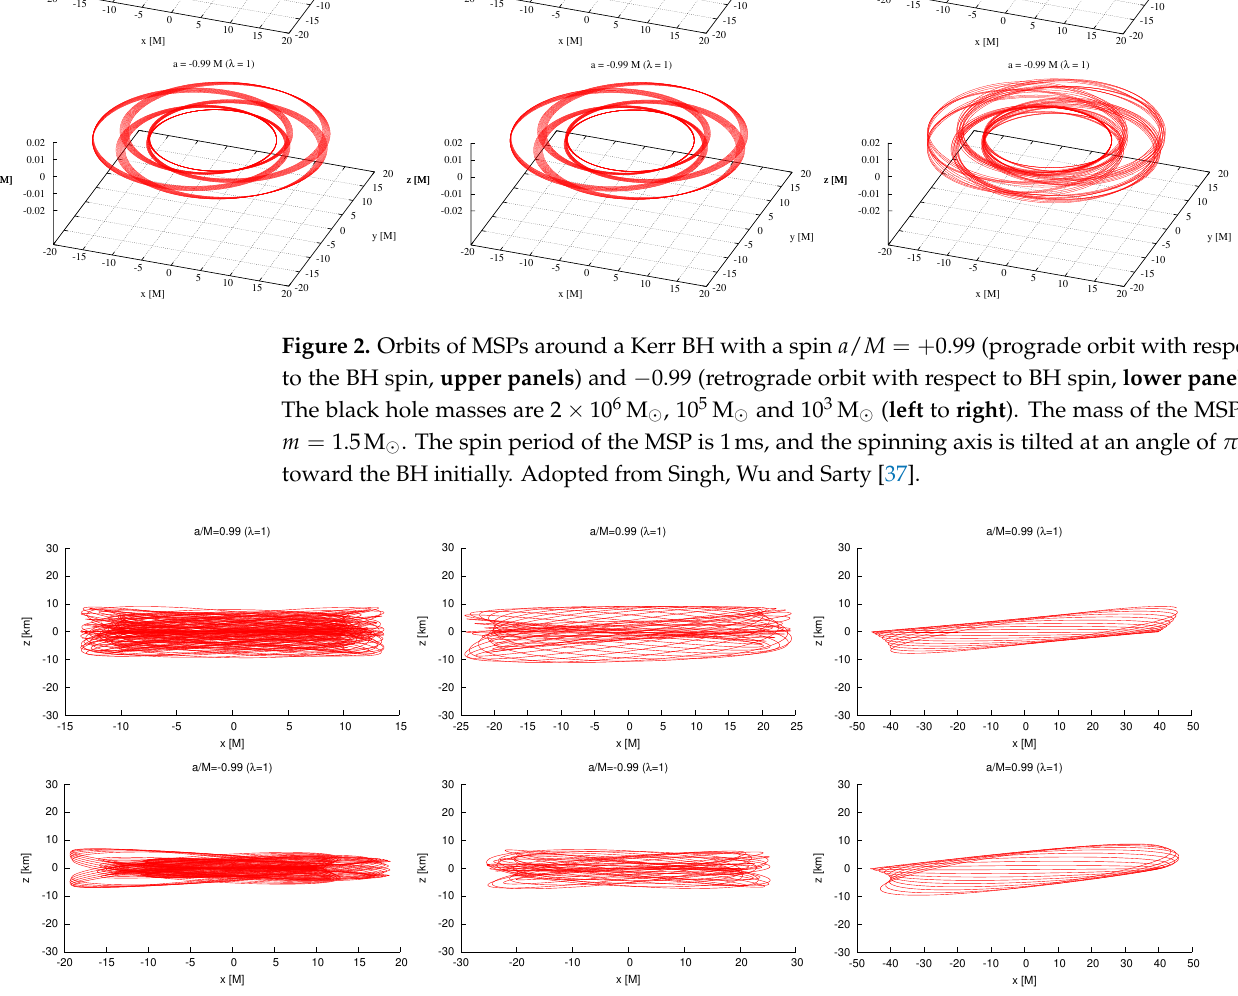
Figure 3. The corresponding projections of the orbits on the x Adopted from Singh, Wu and Sarty